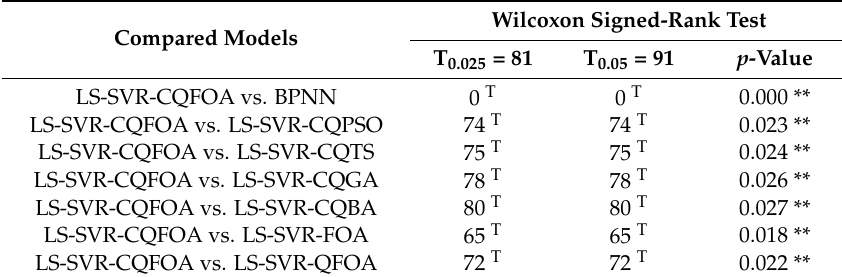
Table 11. Results of Wilcoxon signed-rank test for GEFCom2014